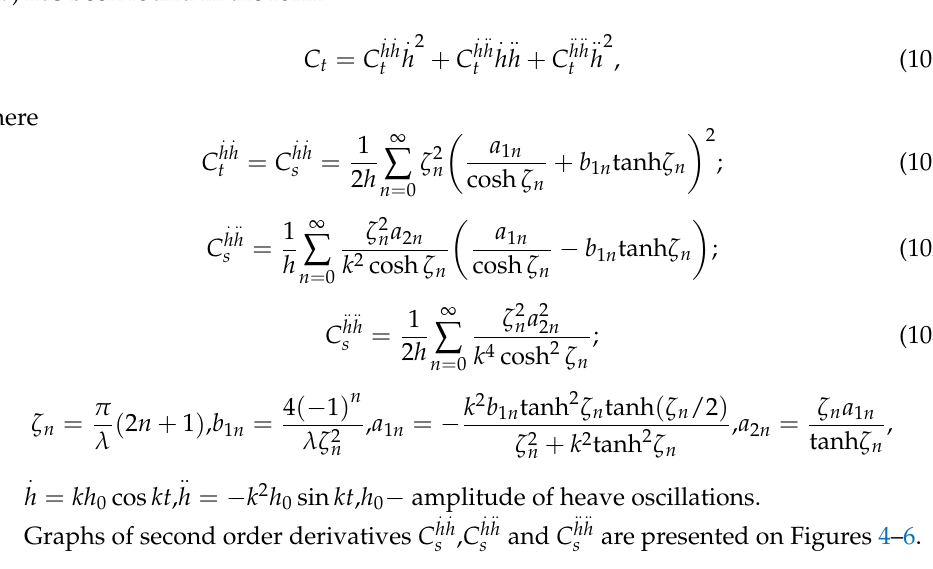
.. hC  for a rectangular wing versus aspect ratio for different Strouhal numbers. Figure 3. Derivative hC h y for a rectangular wing versus aspect ratio for different Strouhal y